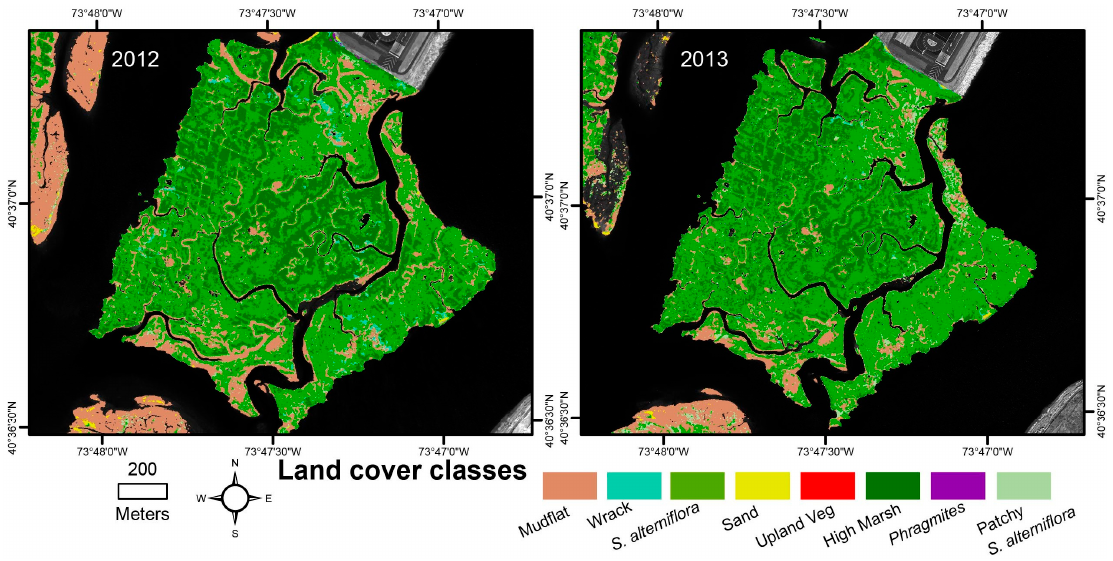
Figure 5. The JoCo salt marsh for 2012 and 2013.